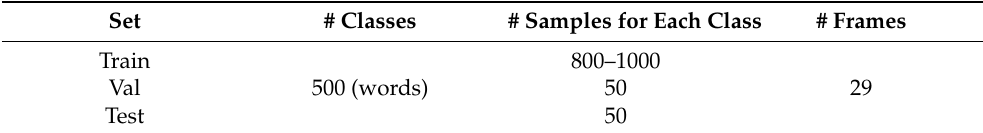
Table 1. LRW dataset characteristics. Set